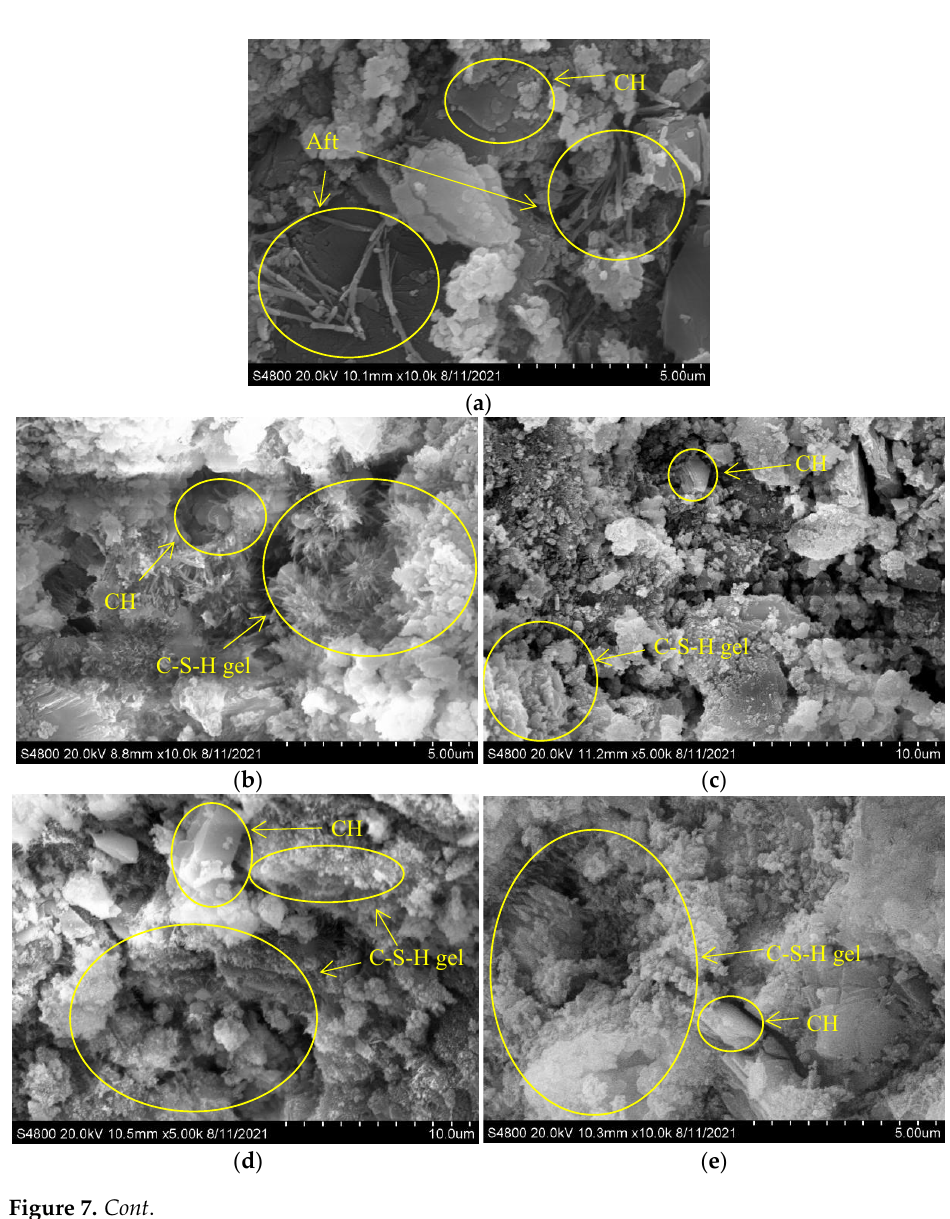
Figure 6. SEM analysis of concrete (water/cement ratio of 0.30). ( a ) 0.30–0/20–28 ° C, ( b ) 0.30–0–200